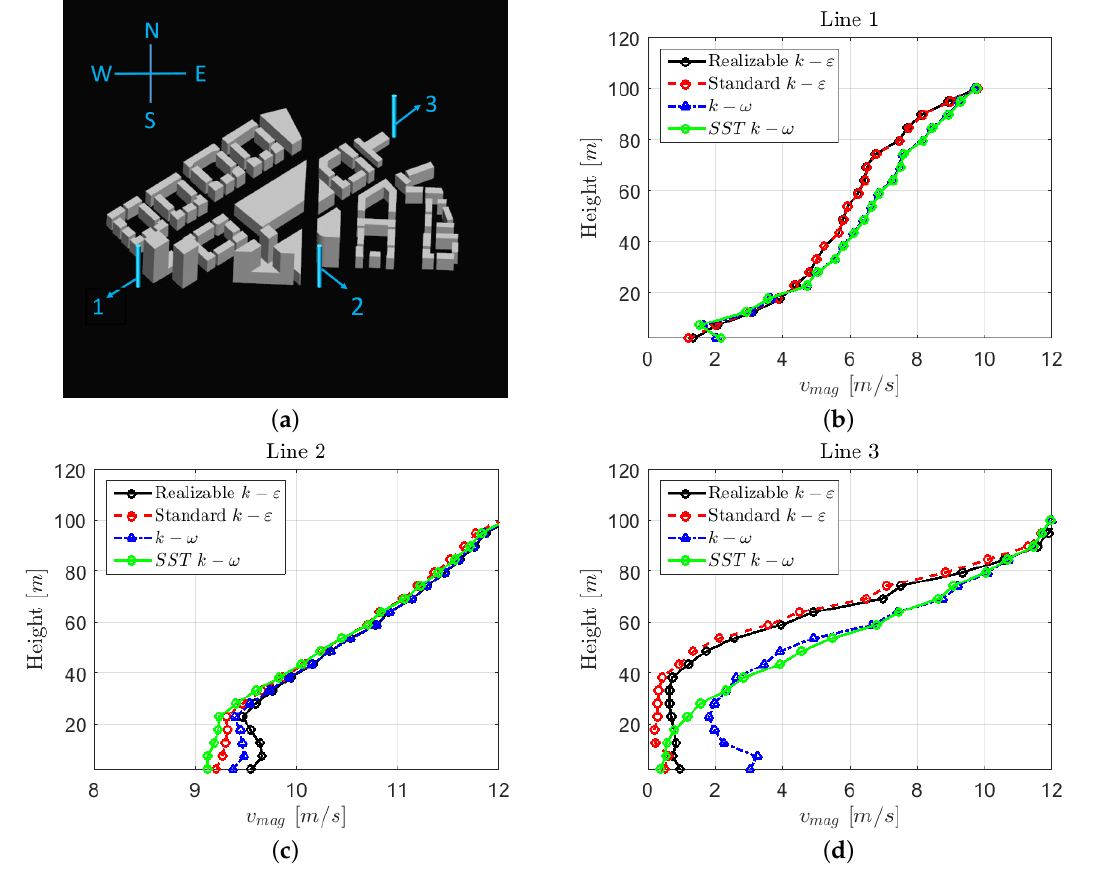
Figure 7. Comparison of various turbulent models at different heights for 3 distinct sections of the geometry: ( a ) target lines for comparison of turbulence models, ( b ) line 1, ( c ) line 2, ( d ) line